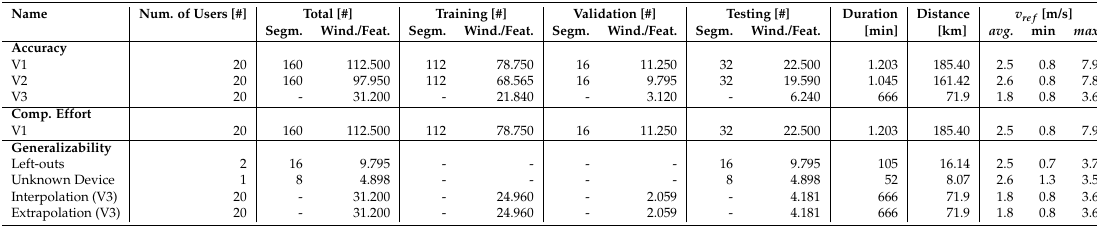
Table 1. Dataset